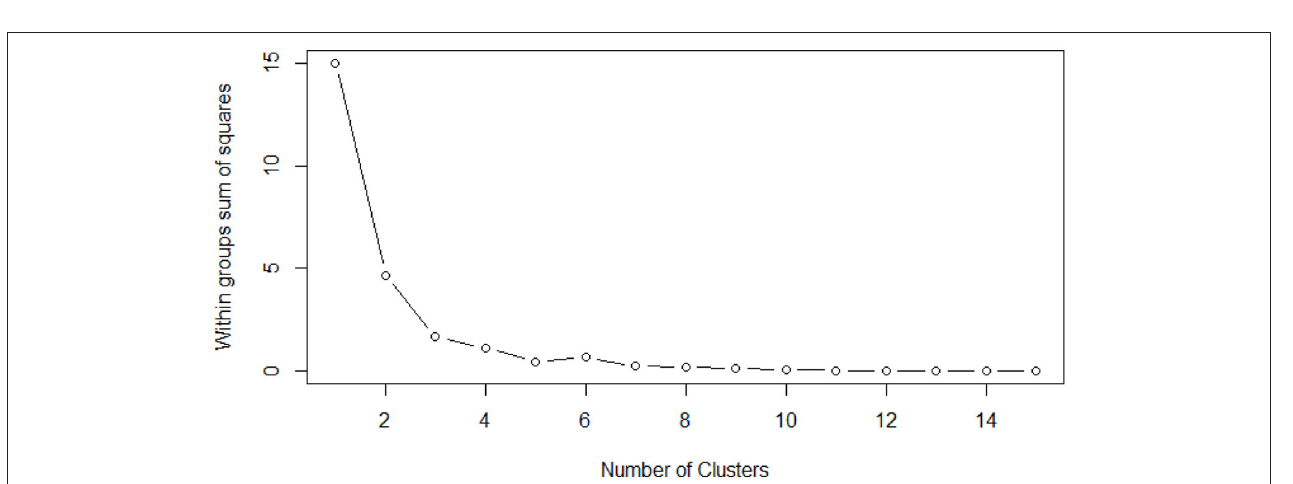
TABLE 4 | Comparing Urban Function interventions with the most effective Vegetation intervention (Geometric Green Wall and Ground). Scenes N Mean S.D. df t Increased Geometric Green Wall and Ground 335 Green Art Gallery